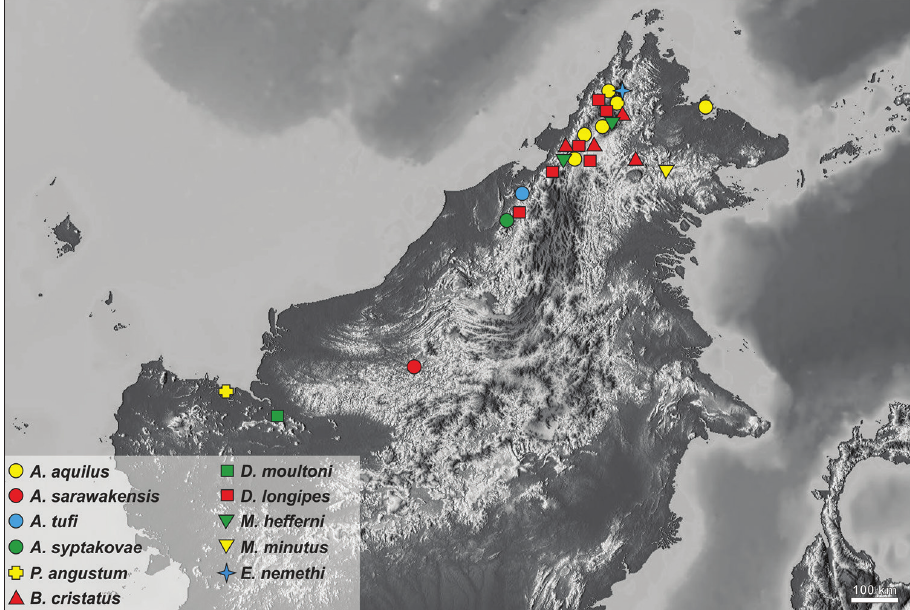
Figure 43. The distribution of Morimopsini in Borneo. A Anexodus Pascoe, B Borneostyrax Gabriš, Kun- drata & Trnka, D Dolichostyrax Aurivillius, E Eurystyrax Gabriš, Kundrata & Trnka, M Microdolichostyrax Gabriš, Kundrata & Trnka, P Pantilema